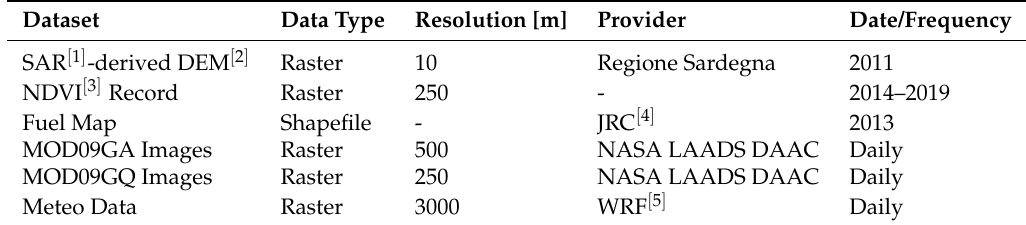
Table 1. Source Data: April 2020